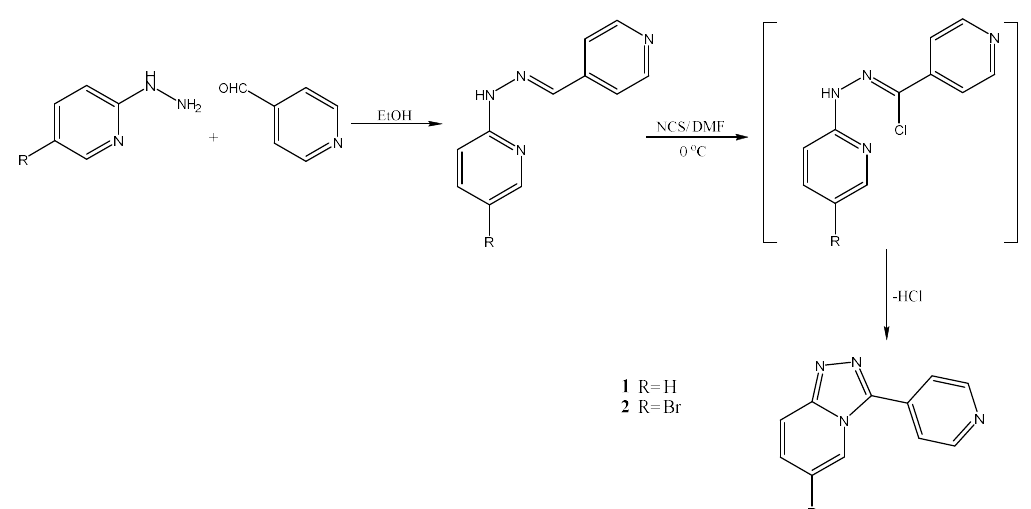
Table 1. Crystal parameters, data collection, and structure refinement details for compounds 1 and 2 .